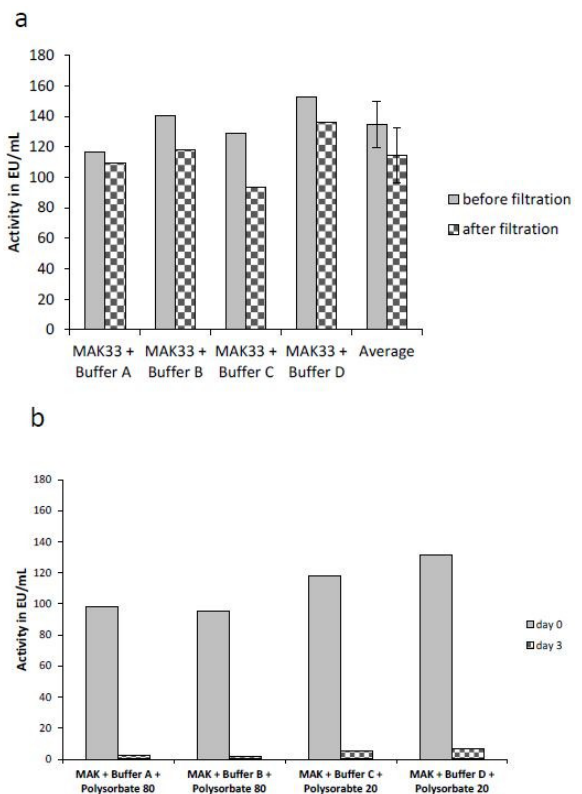
Figure 5. Masking of an endogenous endotoxin contamination. Endotoxin activity of an unknown endotoxin contamination under different buffer conditions is shown. 10 mg/mL monoclonal antibody (MAK33) were solubilized in 25 mM sodium citrate, pH 6.5 (buffer A); 10 mM sodium citrate, pH 7.5 (buffer B); 160 mM trehalose, 50 mM sodium phosphate pH 6.2 (buffer C) and 10 mM sodium phosphate, pH 7.5(buffer D). Endotoxin content was determined before and after sterile filtration (0.2 µ m) ( a ). For endotoxin detection EndoZyme ® was used. After filtration 0.07% (w/v) and 0.05% (w/v) polysorbate 80 were added to the sample in buffer A and B, respectively. 0.04% (w/v) and 0.05% (w/v) polysorbate 20 were added to the sample in buffer C and buffer D, respectively. Endotoxin activity (day 3) at RT ( b ). For endotoxin detection the EndoLISA ® was used.